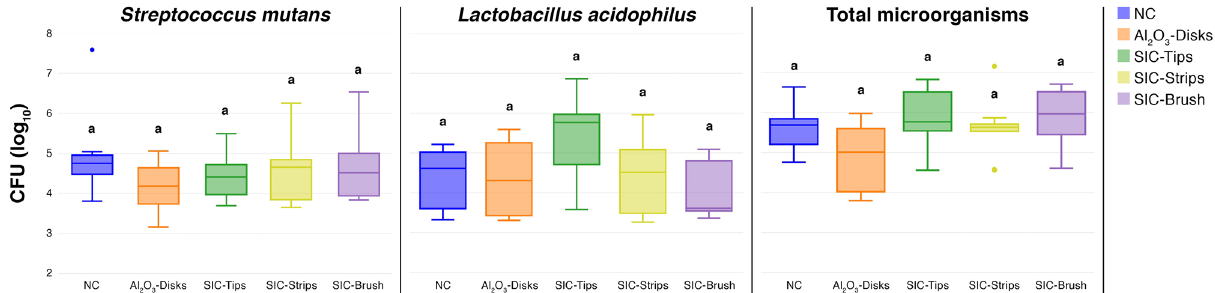
Figure 5. Box-plot diagrams of the colony forming units of total microorganisms, Streptococcus mutans and Lactobacillus acidophilus recovered from the plaque formed over the